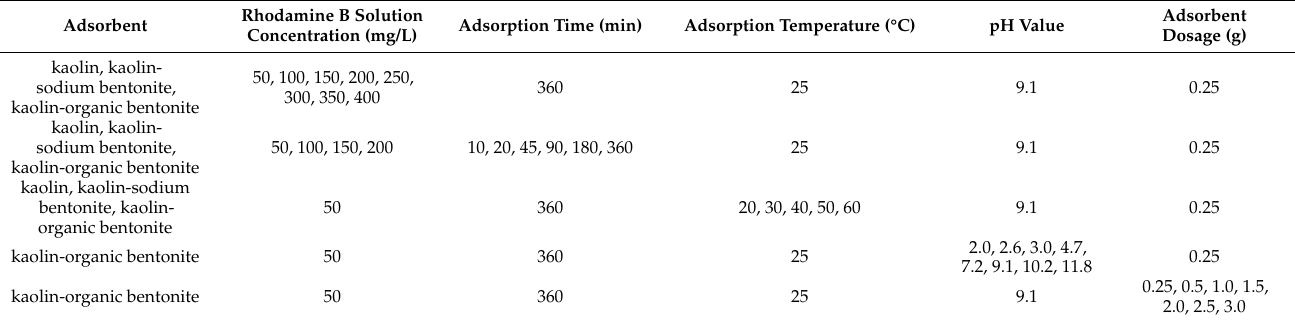
Table 1. Batch adsorption test